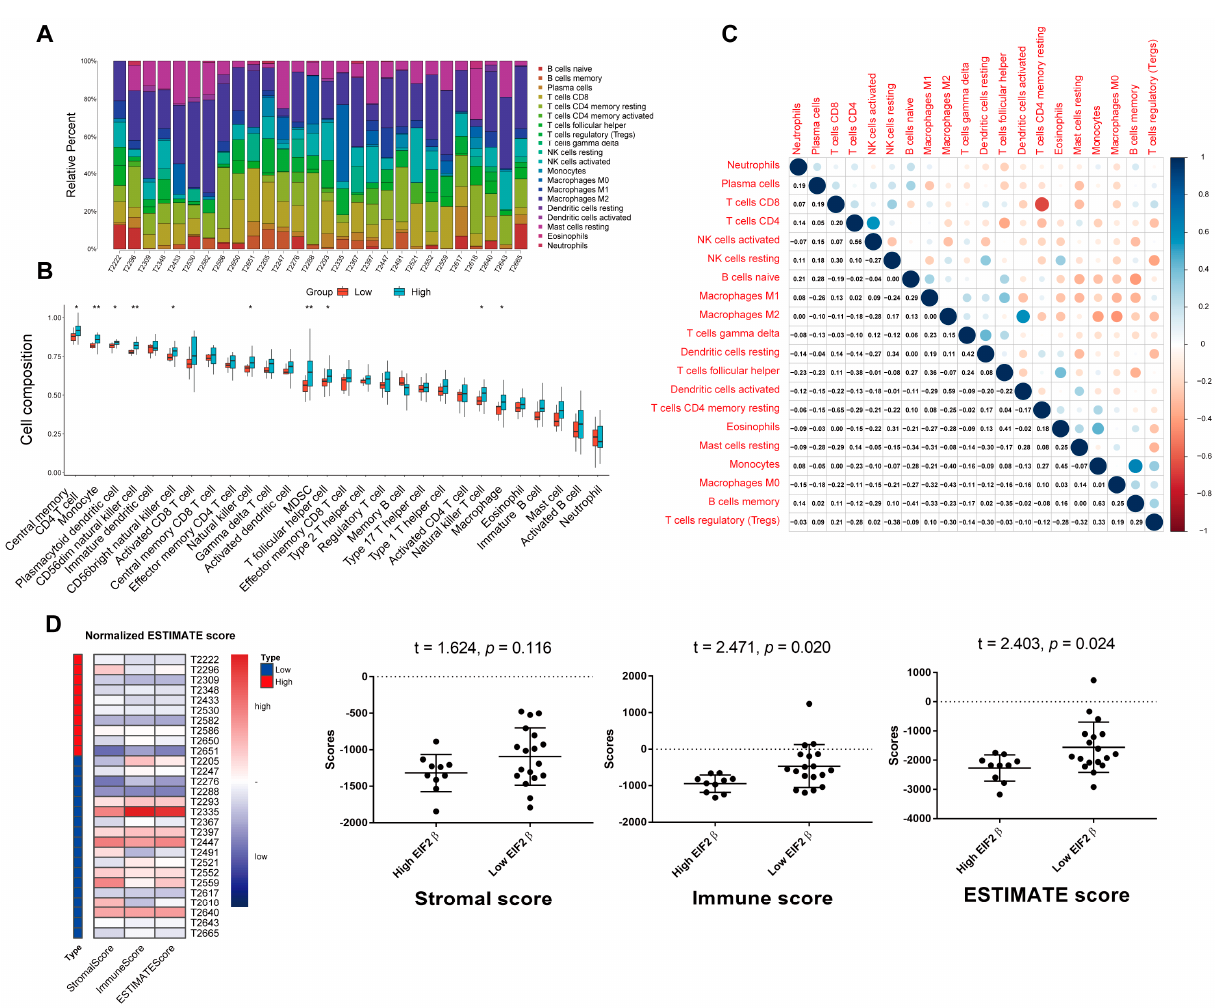
Figure 4. The immune landscape in the high- and low-EIF2 β patient groups. ( A ): Heatmap from immune-cell signatures in 28 patients. ( B ): All 28 subtypes of tumor-infiltrating immune cells in patients with a high EIF2 β compared with patients with a low EIF2 β . The following conventions for symbols indicate statistical significance: blank: p > 0.05; *: p < 0.05; **: p < 0.01. ( C ): Heatmap showing that the ratios of the different tumor infiltration immune cell subgroups were moderately to strongly correlated. ( D ): Immune scores of 28 patients with somatotroph adenomas according to